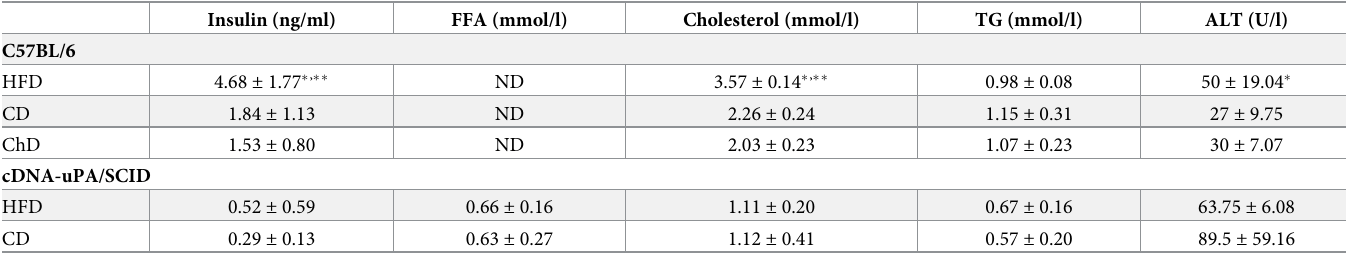
Table 1. Non-fasting serum chemistries.